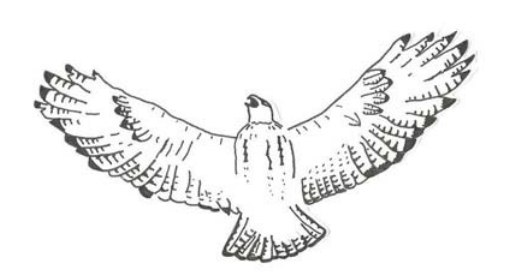
Figure 6. Drawing,